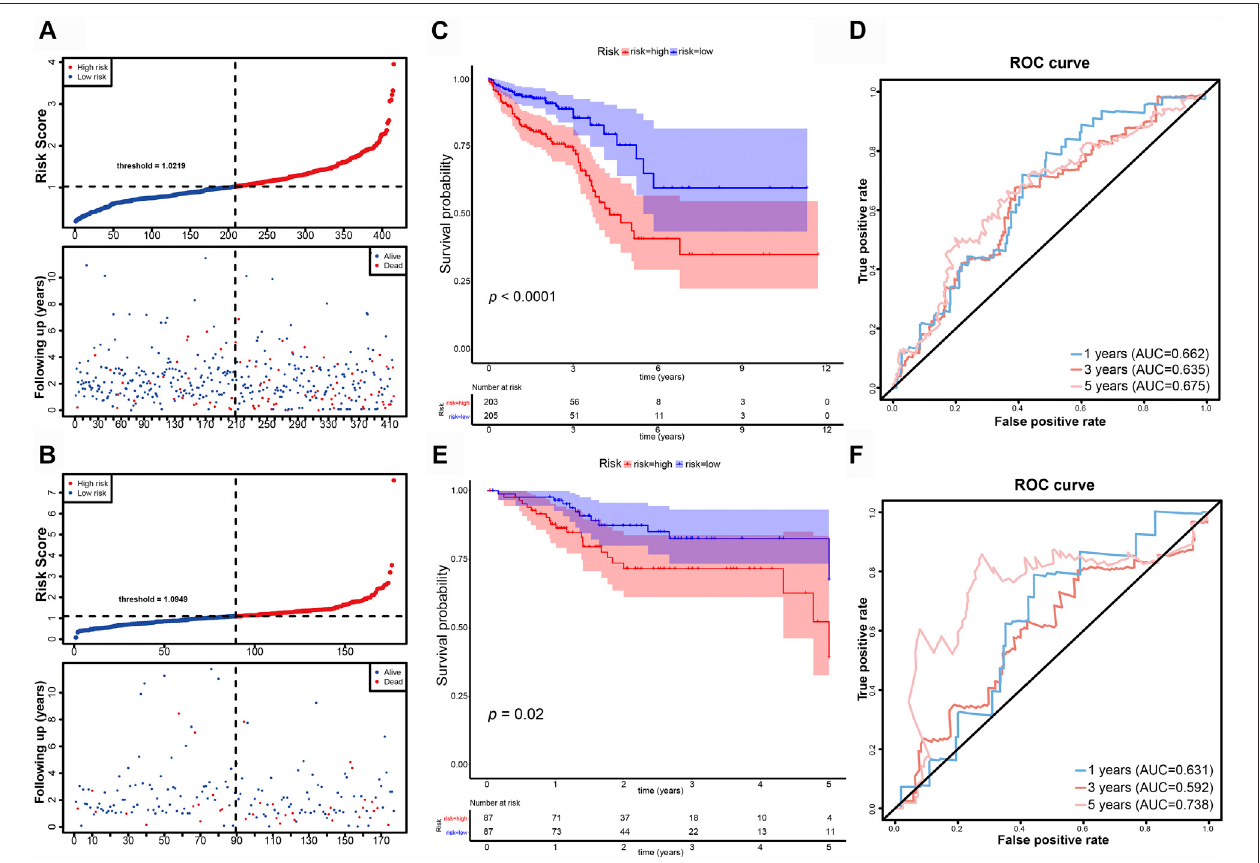
FIGURE 4 | Evaluation and validation of the DE-FLs prognostic signature in CRC patients. (A, B) Distribution and Survival status of CRC patients with different risk scoresintrainingsetandvalidationset. (C) Kaplan – Meiersurvivalcurveofhigh-andlow-riskgroupintrainingset. (D) The1-,3-,and5-yearsROCcurveforriskmodelin training set. (E) Kaplan – Meier survival curve of high- and low-risk group in testing set. (F) The 1-, 3-, and 5-years ROC curve for risk model in testing set.